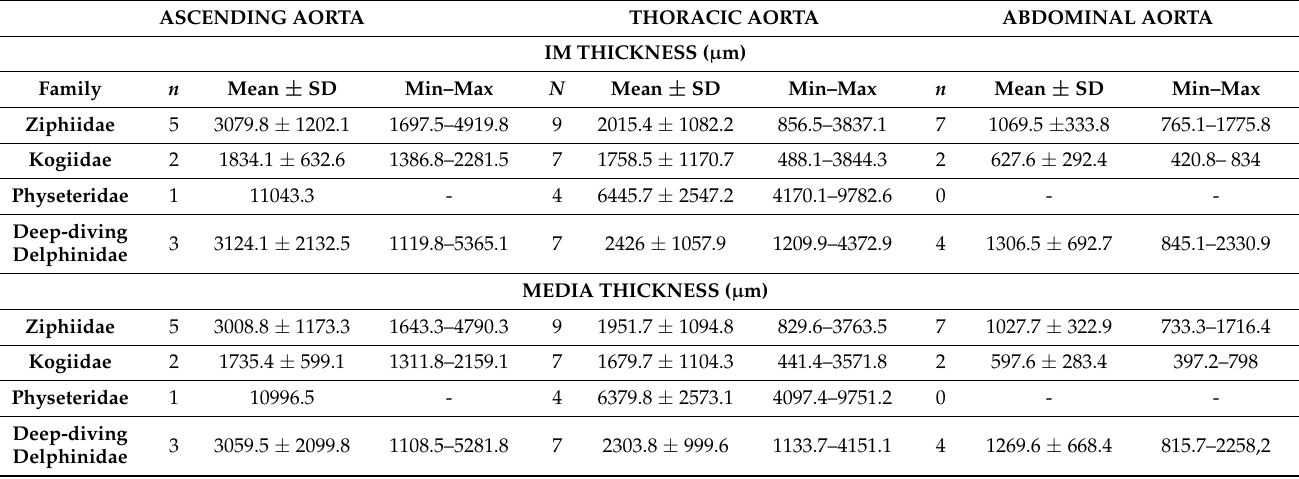
Table 3. Mean and SD, as well as a minimum (Min) and Maximum (Max) values of the IM, tunica media, tunica intima, and elastic thickness, as well as lamellar unit thickness and number by aortic location and